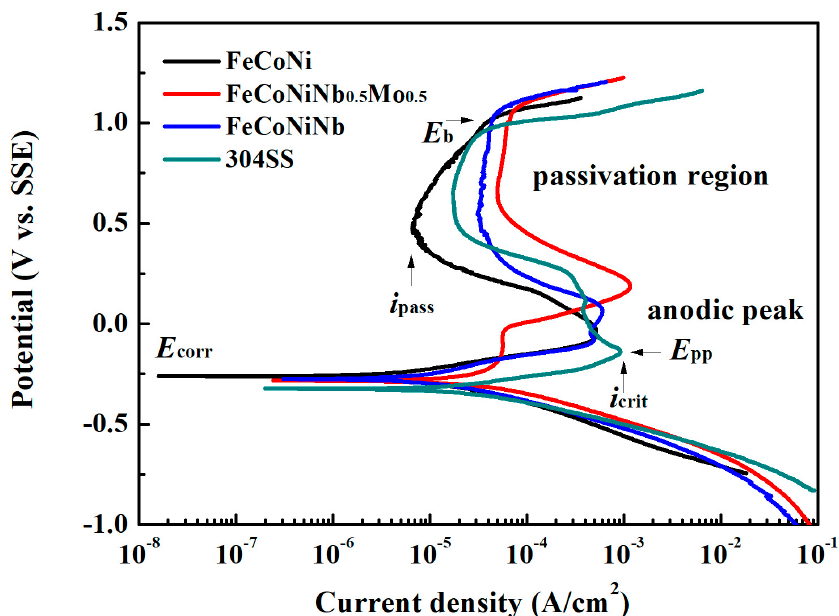
Figure 4. Polarization curves of FeCoNiNb 0.5 Mo 0.5 , FeCoNiNb, FeCoNi and 304SS alloys in 1 M deaerated H 2 SO 4 solution at 30 °C. Table 4. Polarization data ( i corr and E corr ) of FeCoNiNb 0.5 Mo 0.5 , FeCoNiNb, FeCoNi and 304SS alloys in 1 M H 2 SO 4 solution at 30 °C.